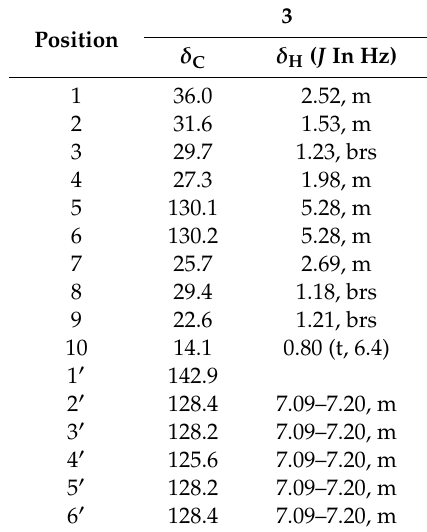
Table 3. 13 C– and 1 H–NMR (400 MHz) data of compound 3 in CDCl 3 .